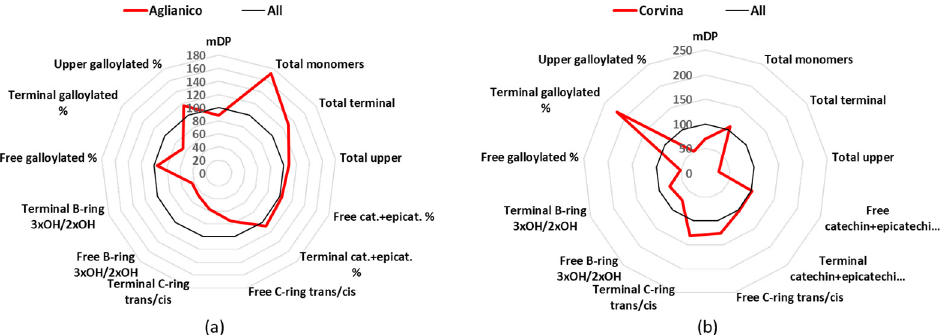
Figure 5. Radar graph comparing the percentage of the relative mean values of Aglianico ( a ) and Corvina ( b ), with the mean values of the 12 groups considered as 100%. cat.: catechin, epicat: epicatechin.